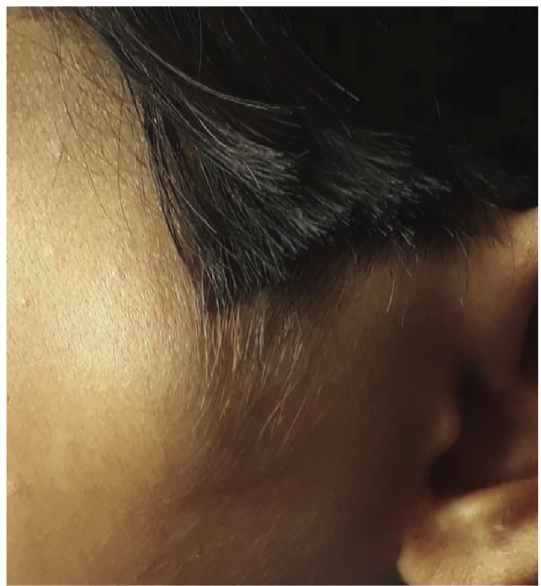
Figure 6: Preoperative clinical picture showing swelling in the left parotid region.